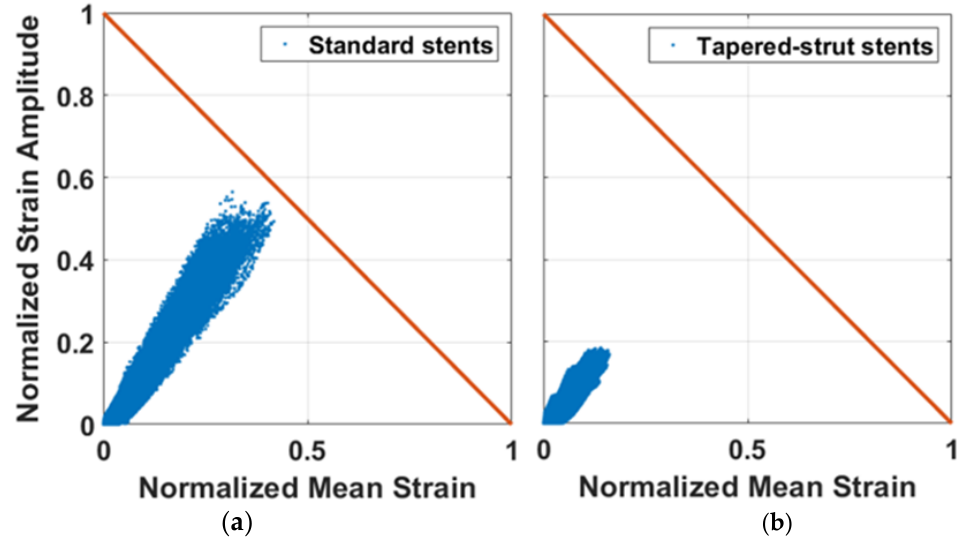
Figure 9. Goodman life analysis of a standard design ( a ) and a 40% tapered-strut design ( b ).